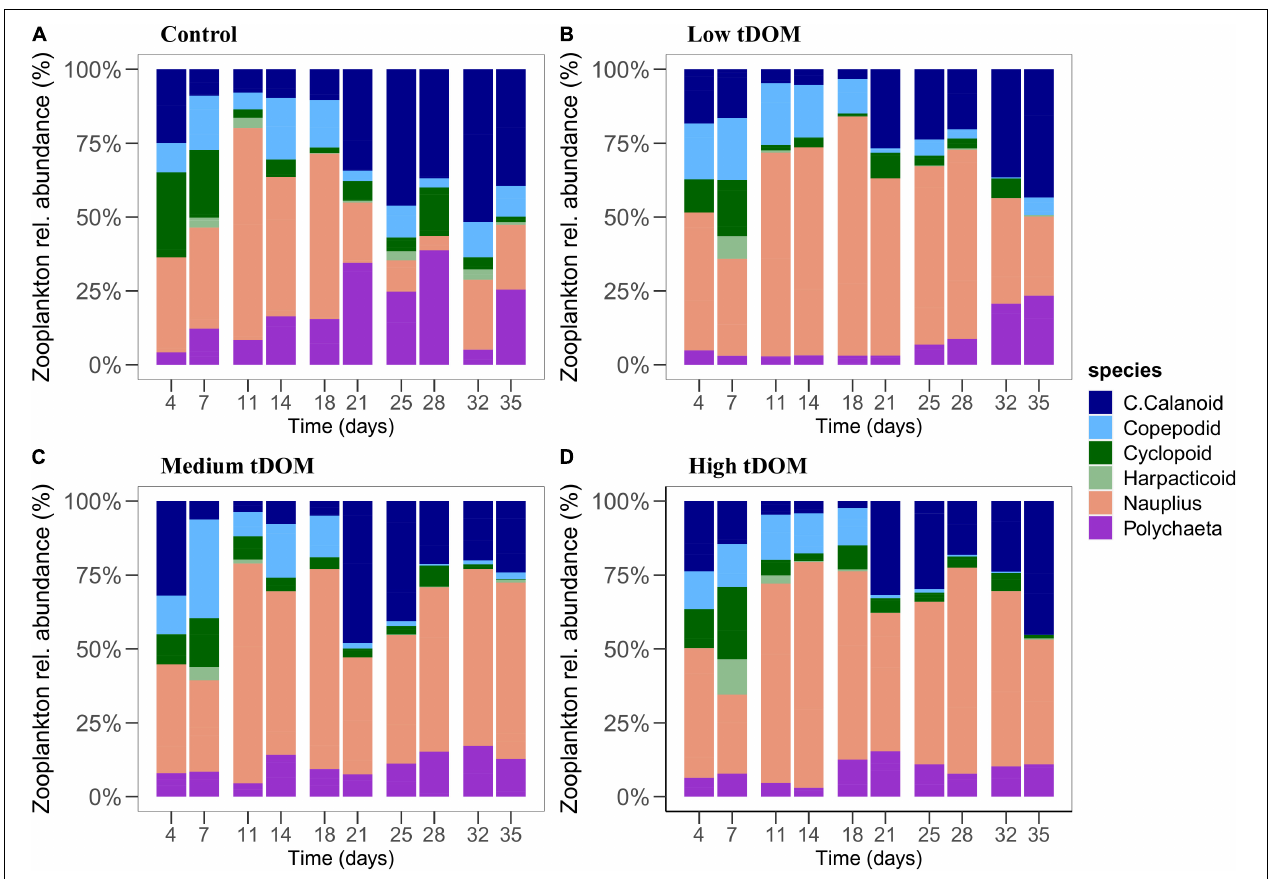
FIGURE 8 | Zooplankton relative abundance (%) of the different treatments over 35 days of the experiment. Panels (A–D) represent control, low tDOM, medium tDOM, and high tDOM treatments,